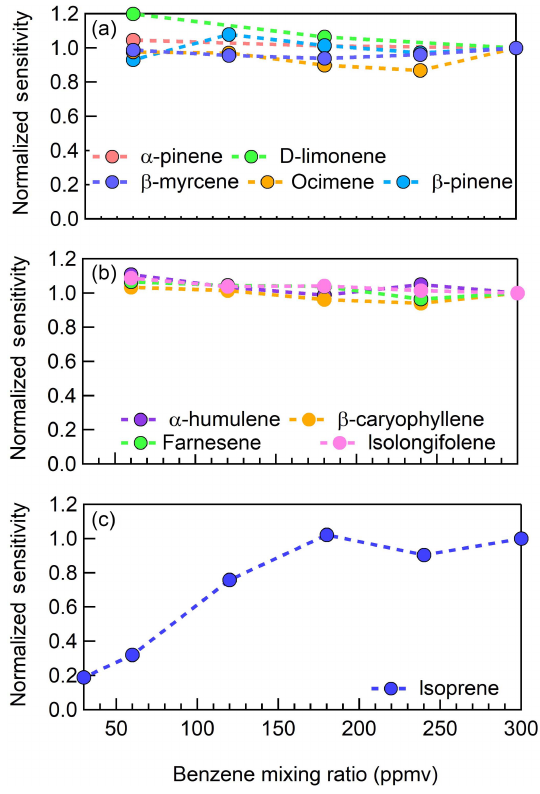
Figure 5. CI-ToFMS sensitivity to (a) monoterpenes (C 10 H + ; 15 136 m/Q ), (b) sesquiterpenes (C 15 H + ; 204 m/Q ), and (c) isoprene 24 · C (C 6 H + 5 H 8 ; 146 m/Q ) as a function of benzene neutral concen- 6 tration normalized to the sensitivity at 300ppmv neutral benzene. Measurements were conducted in nominally dry zero